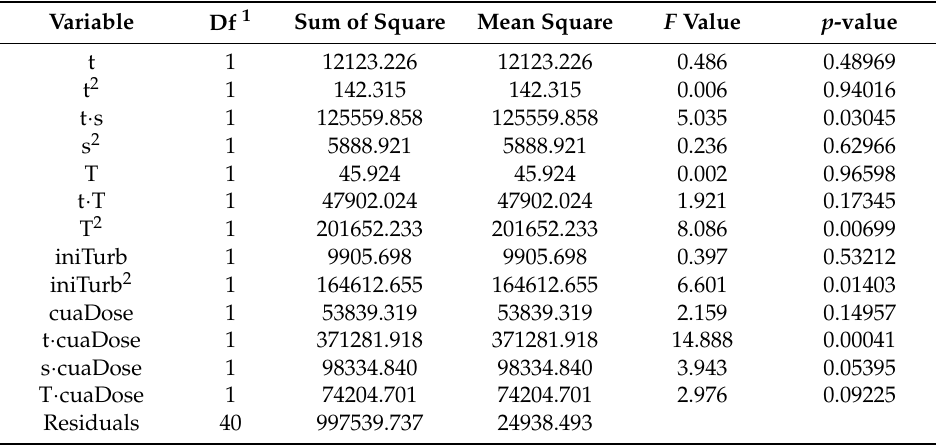
Table 6. ANOVA values for the “TSS” quadratic model for ECOTAN BIO 90D.